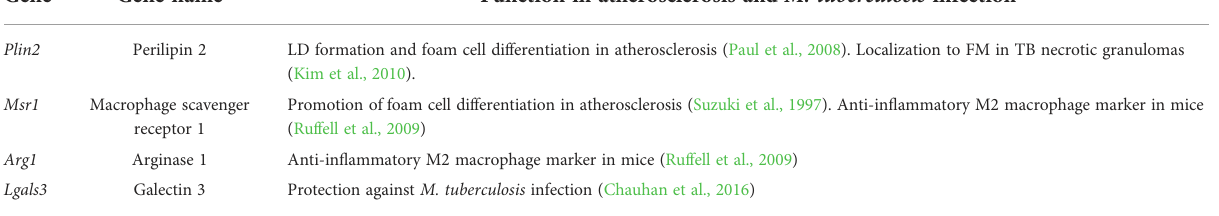
TABLE 1 Candidates of signatures for FM.